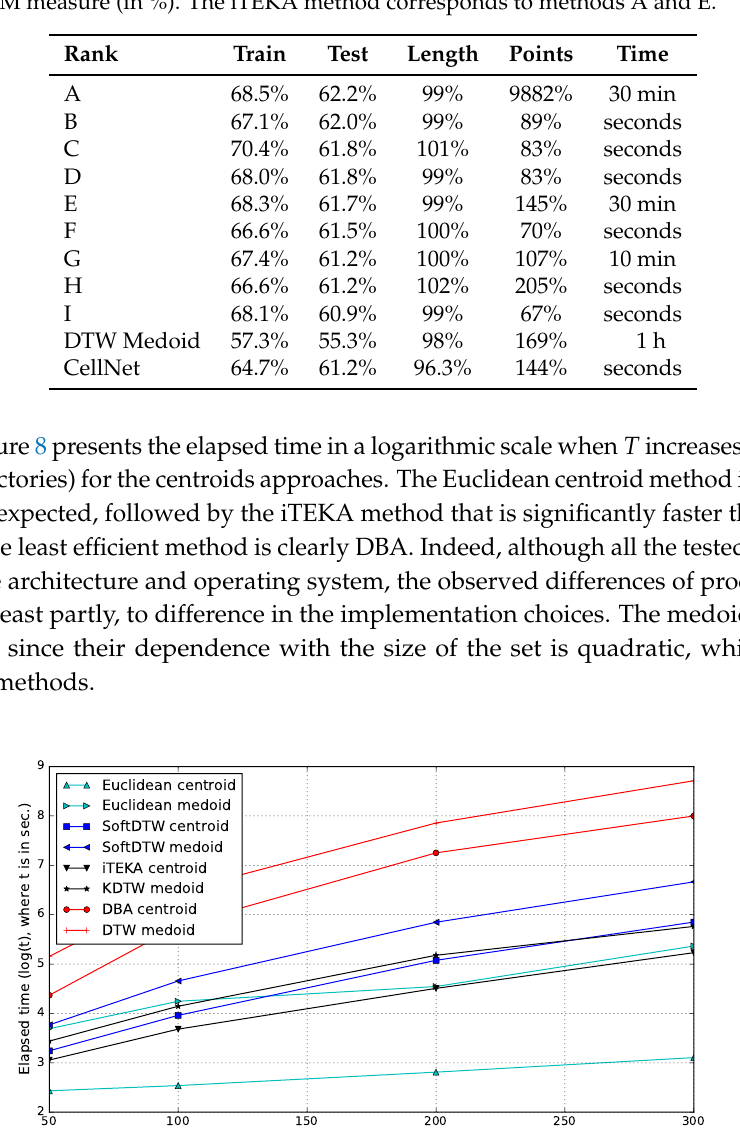
Table 2. Challenge results as produced by the organizers: ranking of the competing methods according to the HC-SIM measure (in %). The iTEKA method corresponds to methods A and E.